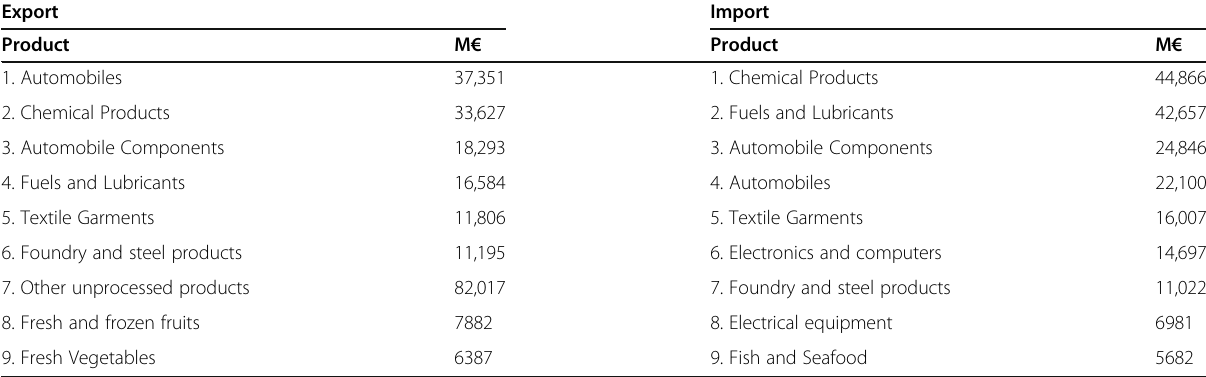
Table 3 Products with the greatest economic impact on Spanish gross domestic product in 2019. Source: [35] Export Import Product M € Product M